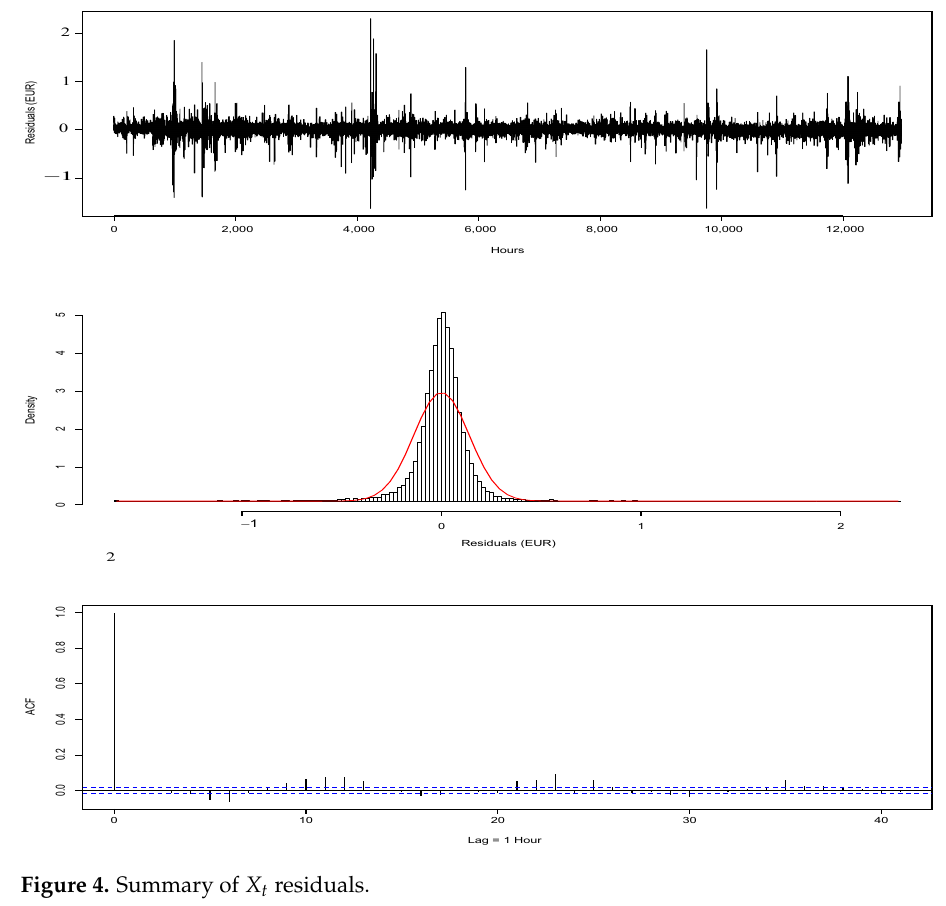
Figure 4. Summary of X t